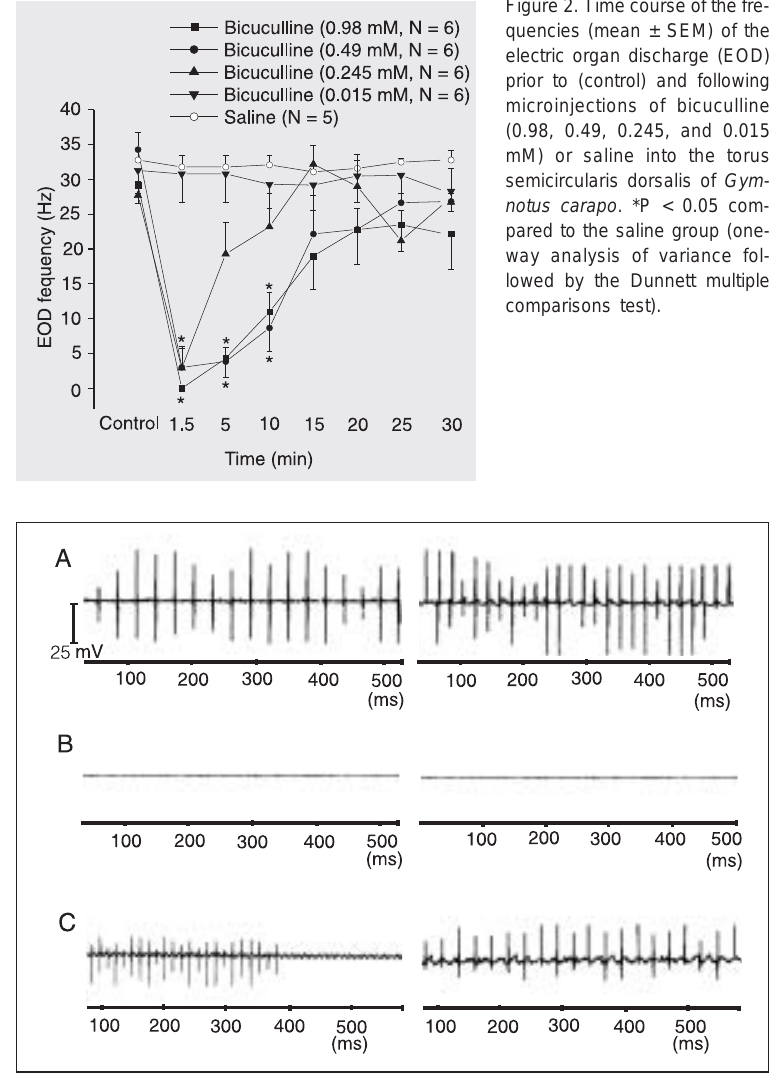
Figure 3. Examples of electric organ discharge in Gymnotus carapo before (left side) and during (right side) application of an alerting stimulus (square wave pulses of 5-ms duration, 70-Hz repetition frequency and a 100-µA current applied to the water of the experimental cuvette) in animals submitted to microinjections of saline (A), 0.98 mM bicuculline (B), and 0.49 mM bicuculline (C) into the torus semicircularis dorsalis. Vertical bar = 25 mV for A, B and